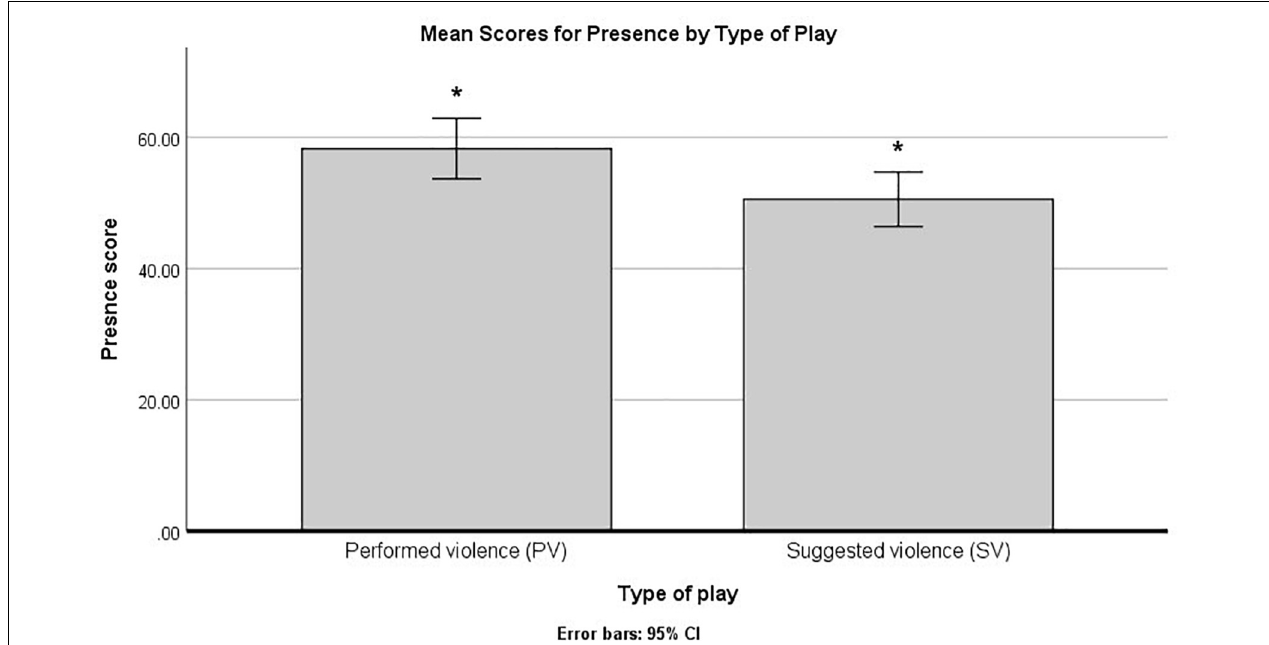
FIGURE 4 | Mean scores for presence by type of play. The bars marked by “*” indicate statistically significant differences and B–H procedure for controlling false discovery rate (FDR).